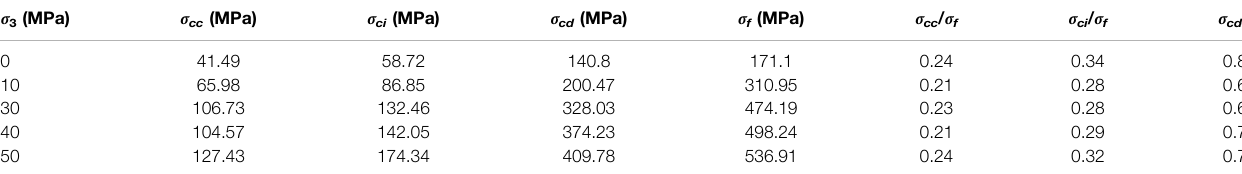
TABLE 3 | Characteristic stress value and its ratio to peak stress under different con fi ning pressures. σ 3